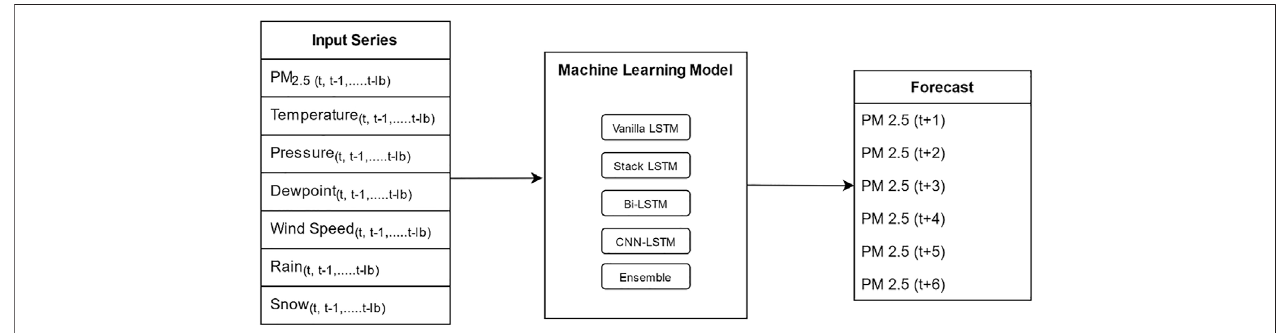
FIGURE 2 | High-level model inputs and